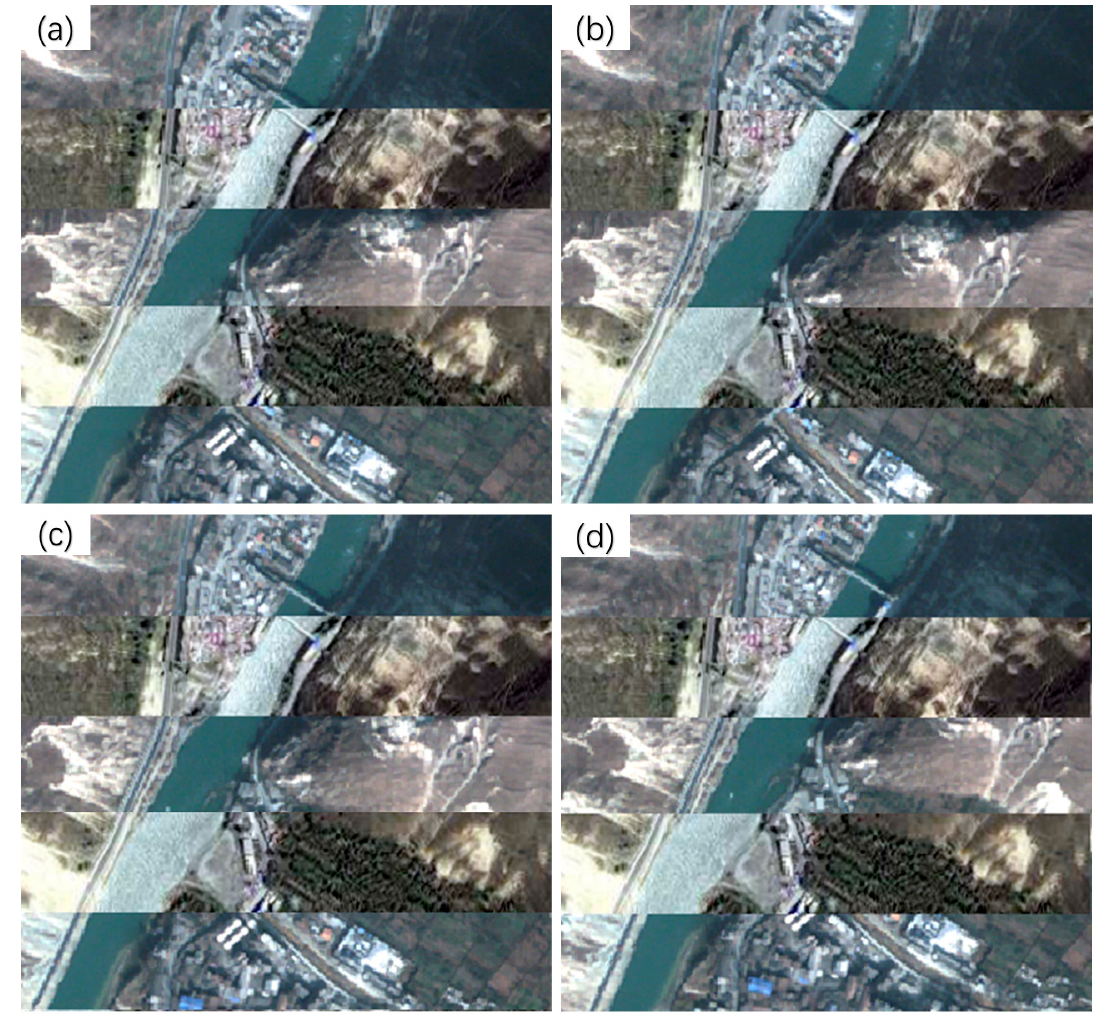
Figure 12. Registered images of the Wenchuan dataset. ( a ) The original image; ( b ) registered image using the proposed method; ( c ) registered image using Patch-SIFT; and ( d ) registered image using SIFT.